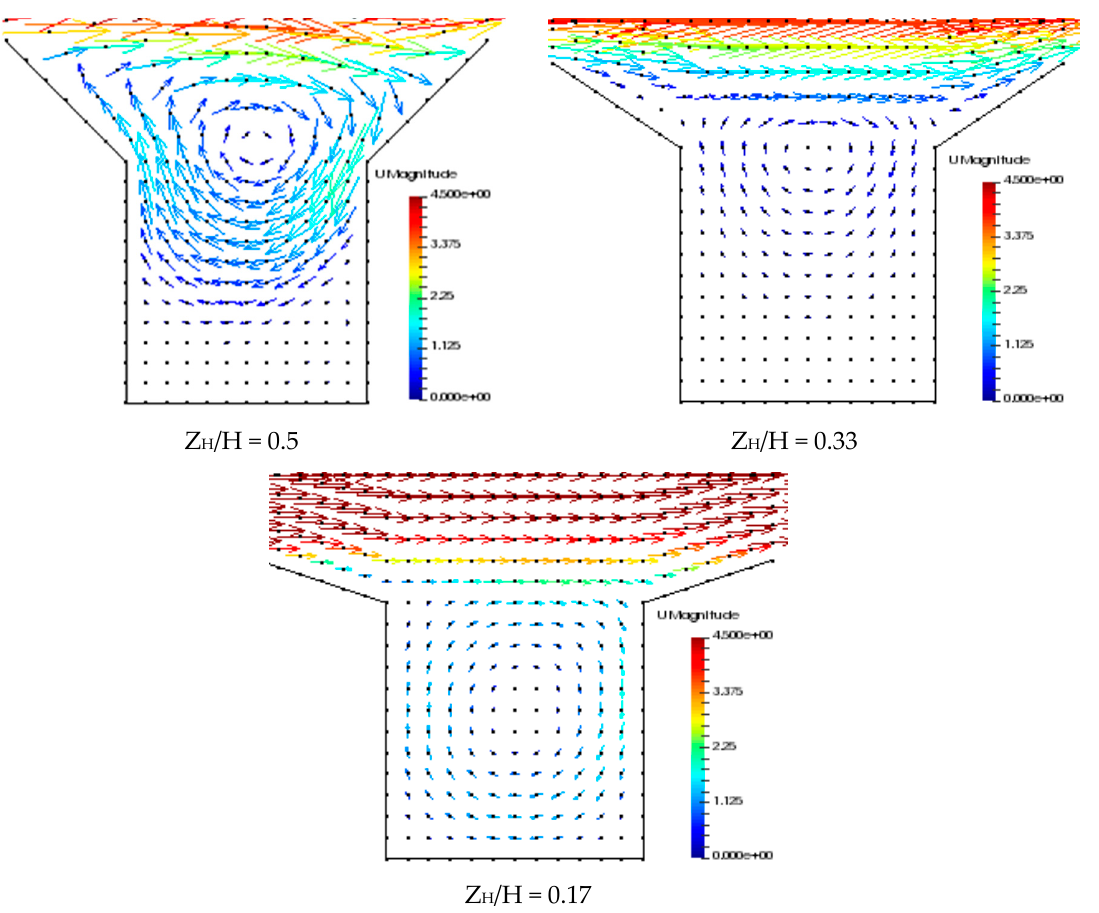
Figure 20. A comparison of the dimensionless concentration K between experiment and computation (with Z H /H = 0.5) at the leeward side (x/B = 0.25) and at the windward side (x/B = 0.75). In addition, the same tendency as in the flat roof case, the vertical pollutant distribution along the leeward side is much larger than those distributed along the windward side. The vertical pollutant concentration drops significantly upward along the leeward side (more than 50%), while it is almost very little changed along the windward side. Figure 21 shows the distribution of pollutant inside the street canyons of slanted roof buildings with different roof slopes; Z H /H = 0.50, 0.33 and 0.17, respectively. This again shows that the pollutant concentration at the leeward side is always larger than at the windward side for the slopes (Z H /H) of